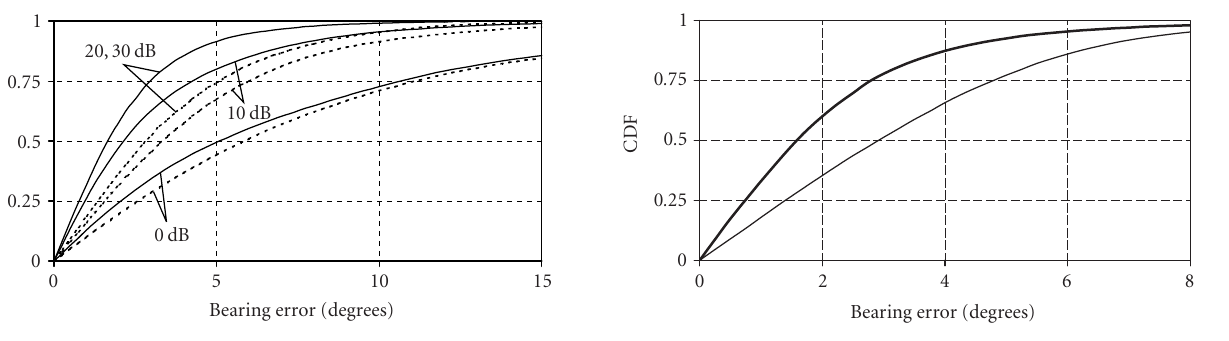
Figure 9: The CDF of the bearing estimation error using the “spread” bearing curve (thick curve) and “point source” bearing curve (thin curve) for SNR = 30dB, angle spread ∆ = 17 ◦ , and number of scatterers N =